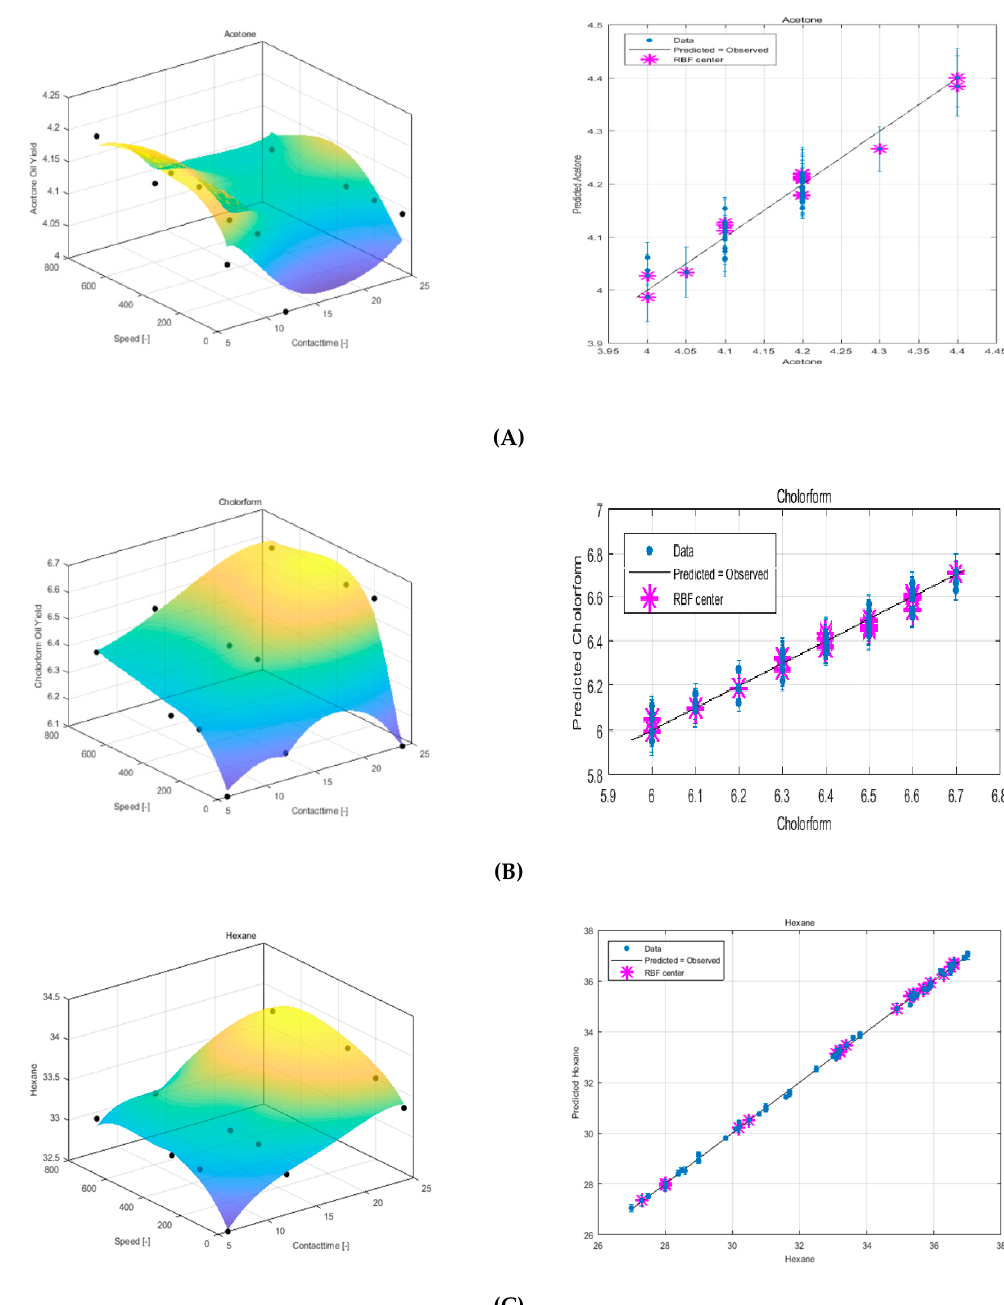
Figure 3. Response surface plot of using LRBF and experimental versus predicted data for sesame seed oil extraction using ( A ) acetone, ( B ) chloroform, and ( C ) hexane